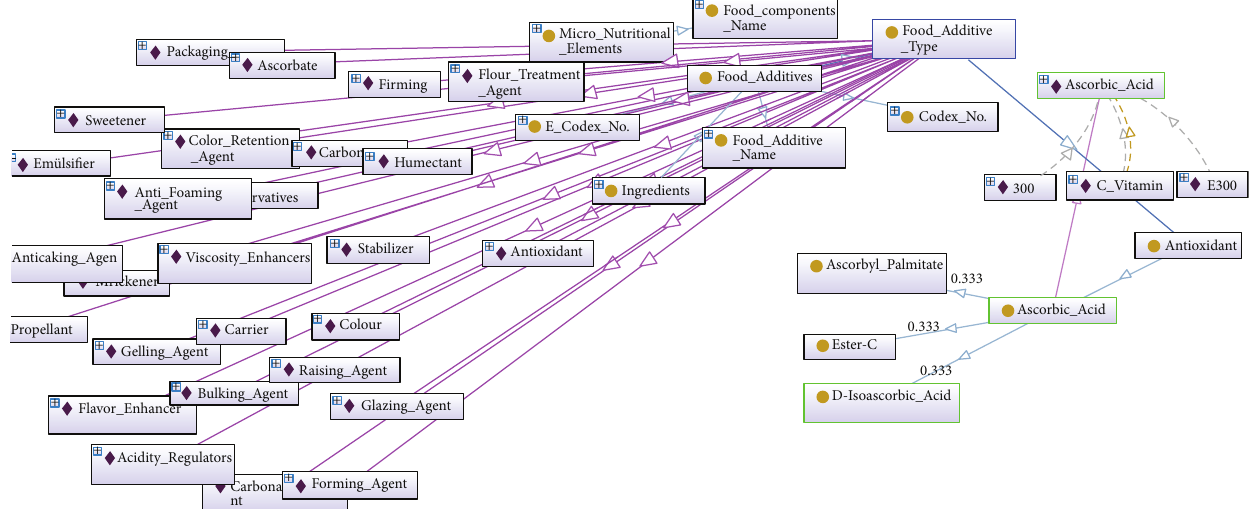
Figure 5: Ester C , Ascorbyl Palmitate ( Vitamin C Ester ), and D-Isoascorbic Acid ( Erythorbic Acid ) are three subconcepts of the Ascorbic Acid concept, and each link has 0.333 weight